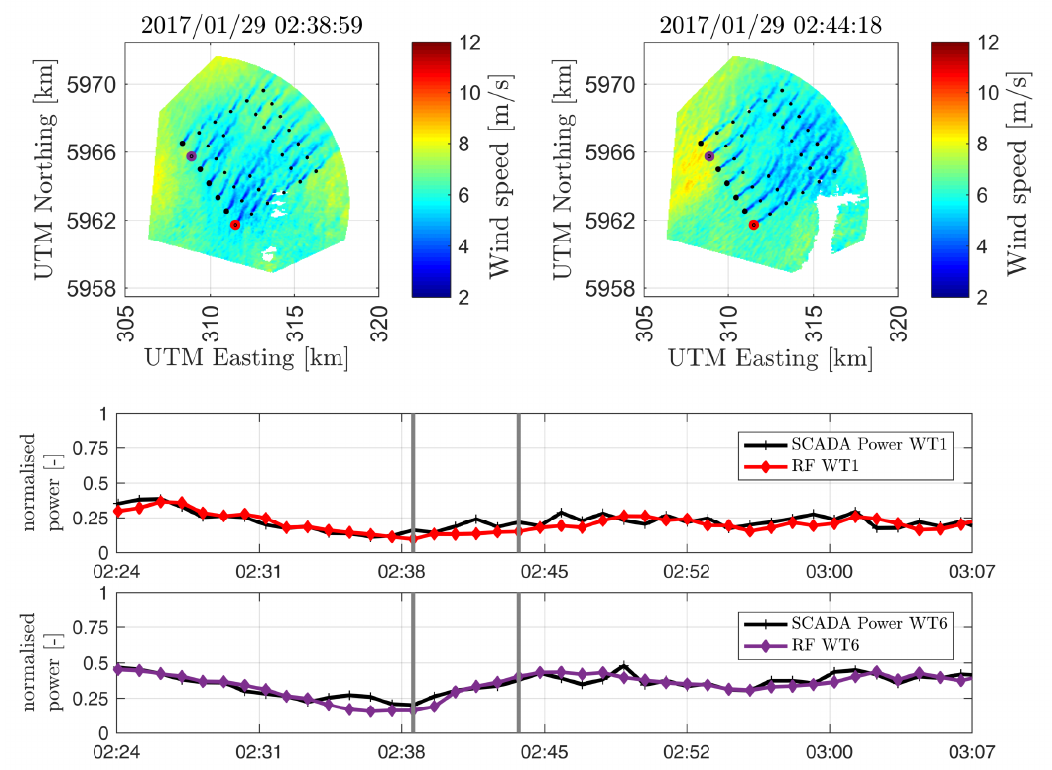
Figure 13. ( Top ) two radar observed wind fields about five minutes apart; ( Bottom ) time series of power produced and predicted with the remote sensing-based forecasting (RF) model for the wind turbines WT 1 and WT 6. Grey lines indicate the two timestamps above the top